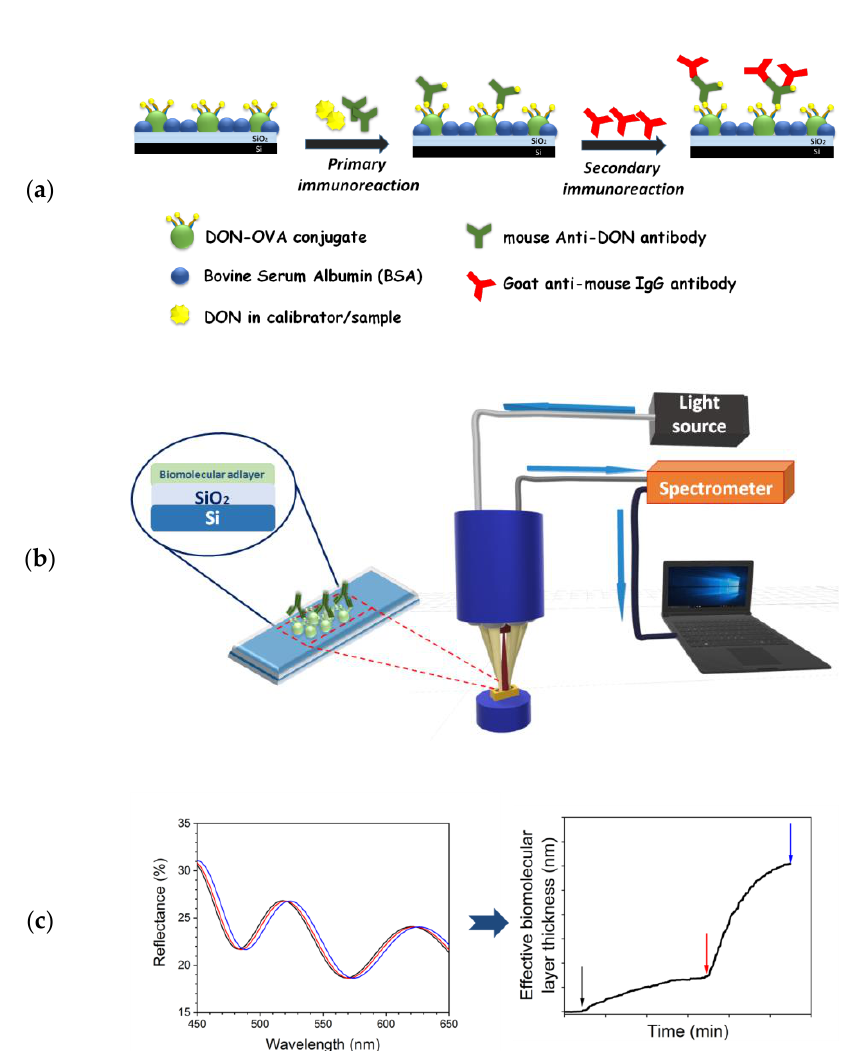
Figure 2. ( a ) Schematic of the immunoassay format and steps. ( b ) Schematic of the instrumentation employed for DON determination. ( c ) The transformation of spectral shifts due to primary (red line in the left graph) and the secondary immunoreaction (blue line in the left graph) with respect to baseline (black line in the left graph) to “effective biomolecular layer thickness” (the black, red and blue arrows in the right graphs correspond to baseline, end of primary immunoreaction, and end of secondary immunoreaction, respectively).